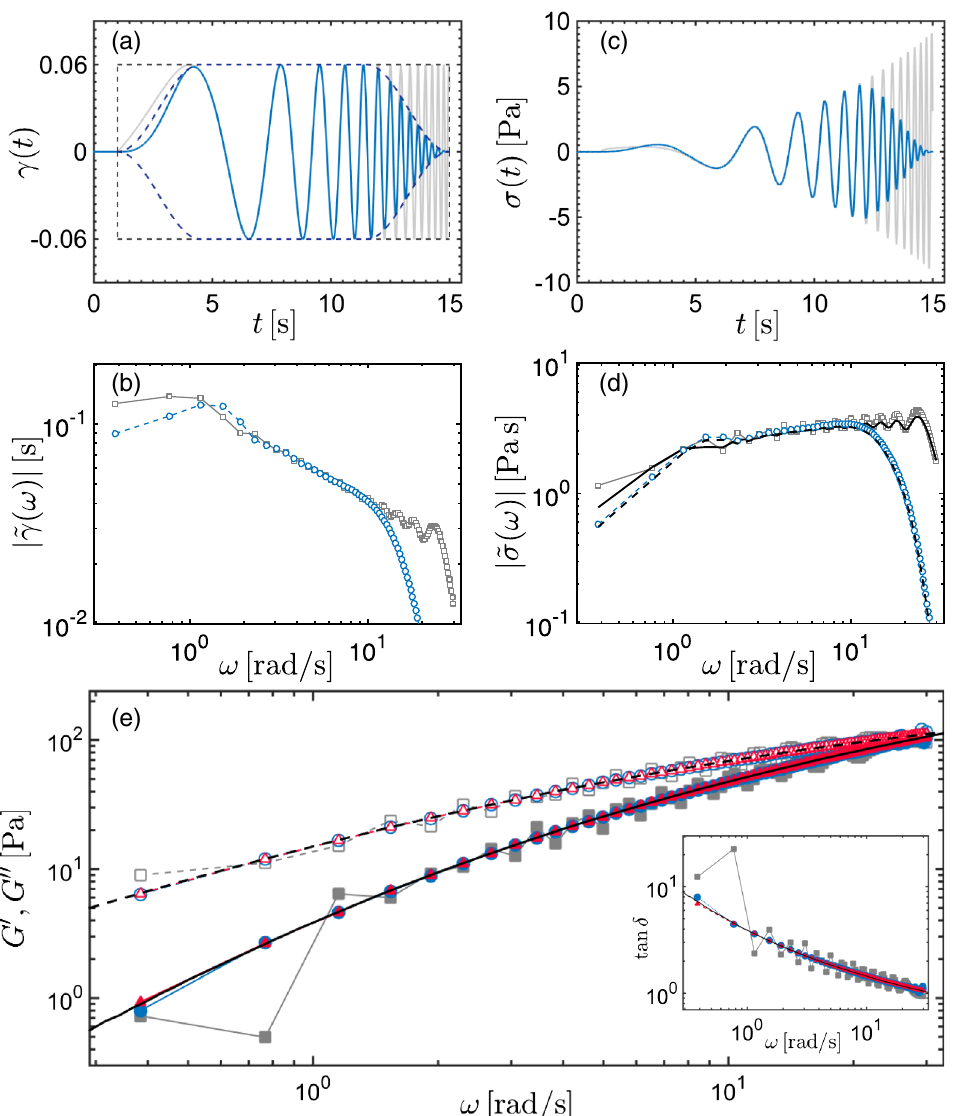
FIG. 2. Data presented are from experiments on the reference PIB solution. All chirp signals have the following parameters: 0 . 3 rad = s, ω 30 rad = s, γ 0 . 06 , and T ¼ 14 s ( TB ≃ 66 ) but different degrees of tapering, i.e., different values of r . (a) Sine ω 1 ¼ 2 ¼ 0 ¼ sweep in strain γ ð t Þ (as proposed by Ghiringhelli et al. [46]) with constant signal amplitude r ¼ 0 (grey line). The enclosing dashed line emphasizes the square nature of the signal envelope. Superposed is a windowed chirp with r ¼ 50% (blue line) together with its tapered 1 s as described in the text. (b) Single-sided amplitude spectrum of the envelope (dark blue dashed line). Both signals begin at time t w ¼ strain signal for the same values of the tapering parameter r as in (a): r ¼ 0 (grey solid line and square) and r ¼ 50% (blue dashed line and circle). (c) Measured stress response as a function of the time corresponding to the input signals of (a): r ¼ 0 (grey line) and r ¼ 50% (blue line). (d) Single-sided amplitude spectrum of the stress signals shown in (c). Data from the measured stress ( r ¼ 0 , grey solid line and square; r ¼ 50% , blue dashed line andcircle) are comparedto the error-free spectrum ( r ¼ 0 ,black solid line; r ¼ 50% ,blackdashed line) obtained in the frequency domain by multiplying the theoretical transfer function from the fractional Maxwell model, i.e., the complex modulus G ⋆ ð ω Þ of the material, and the DFT of the experimental strain input. (e) Comparison of the viscoelastic moduli G ⋆ ð ω Þ ¼ G 0 ð ω Þ þ iG 00 ð ω Þ obtained by a classical frequency sweep ( G 0 , black solid line; G 00 , black dashed line) with the results obtained from a windowed chirp with different tapering parameters: r ¼ 0 ( G 0 , grey solid line and filled square; G 00 , grey dashed line and open square), r ¼ 10% ( G 0 , red solid line and filled triangle; G 00 , red dashed line and open triangle), and r ¼ 50% ( G 0 , blue solid line and filled circle; G 00 , blue dashed line and open circle). The inset shows tan δ ð ω Þ ¼ G 00 ð ω Þ =G 0 ð ω Þ (the same color code and symbols as in the main graph).